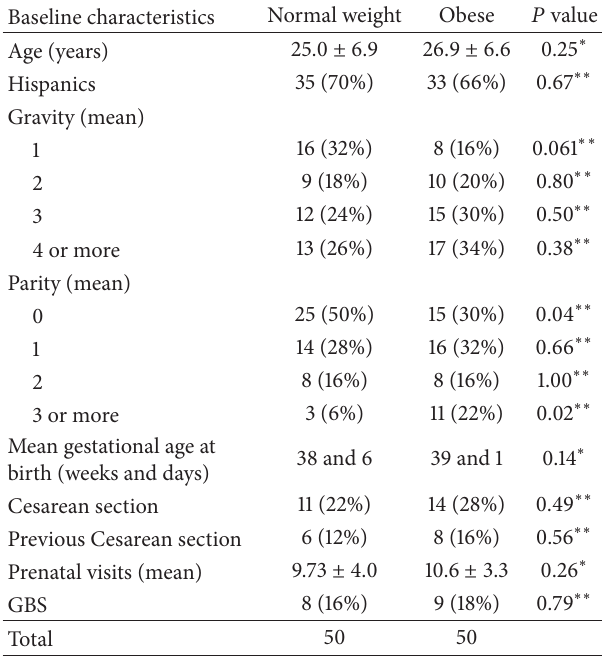
Table 1: Baseline characteristics of normal weight and obese